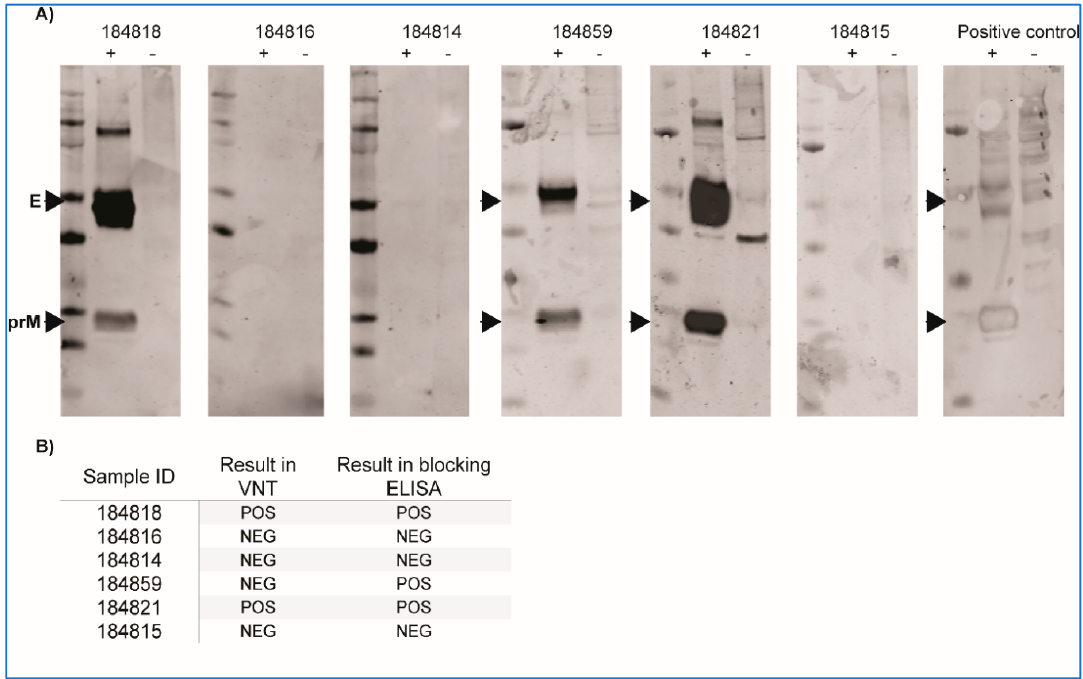
Figure 1. Antibody responses in farmed saltwater crocodiles with (184818, 184821) and without “pix” skin lesions. ( A ) Western blot using serum samples from crocodiles presenting with skin lesions and lesion-free animals from the same farm were used to probe WNV KUN (strain MRM61C) cell lysate ( + ) or mock-infected cell lysate ( − ). Signal for envelope (E) and pre-membrane (prM) proteins are observed at approximate molecular weights of 50 and 20 kDa, respectively. WNV KUN -reactive horse serum was used as positive control. ( B ) Reactivity of the same serum samples in virus neutralisation test (VNT) and blocking ELISA. POS—positive, NEG—negative.